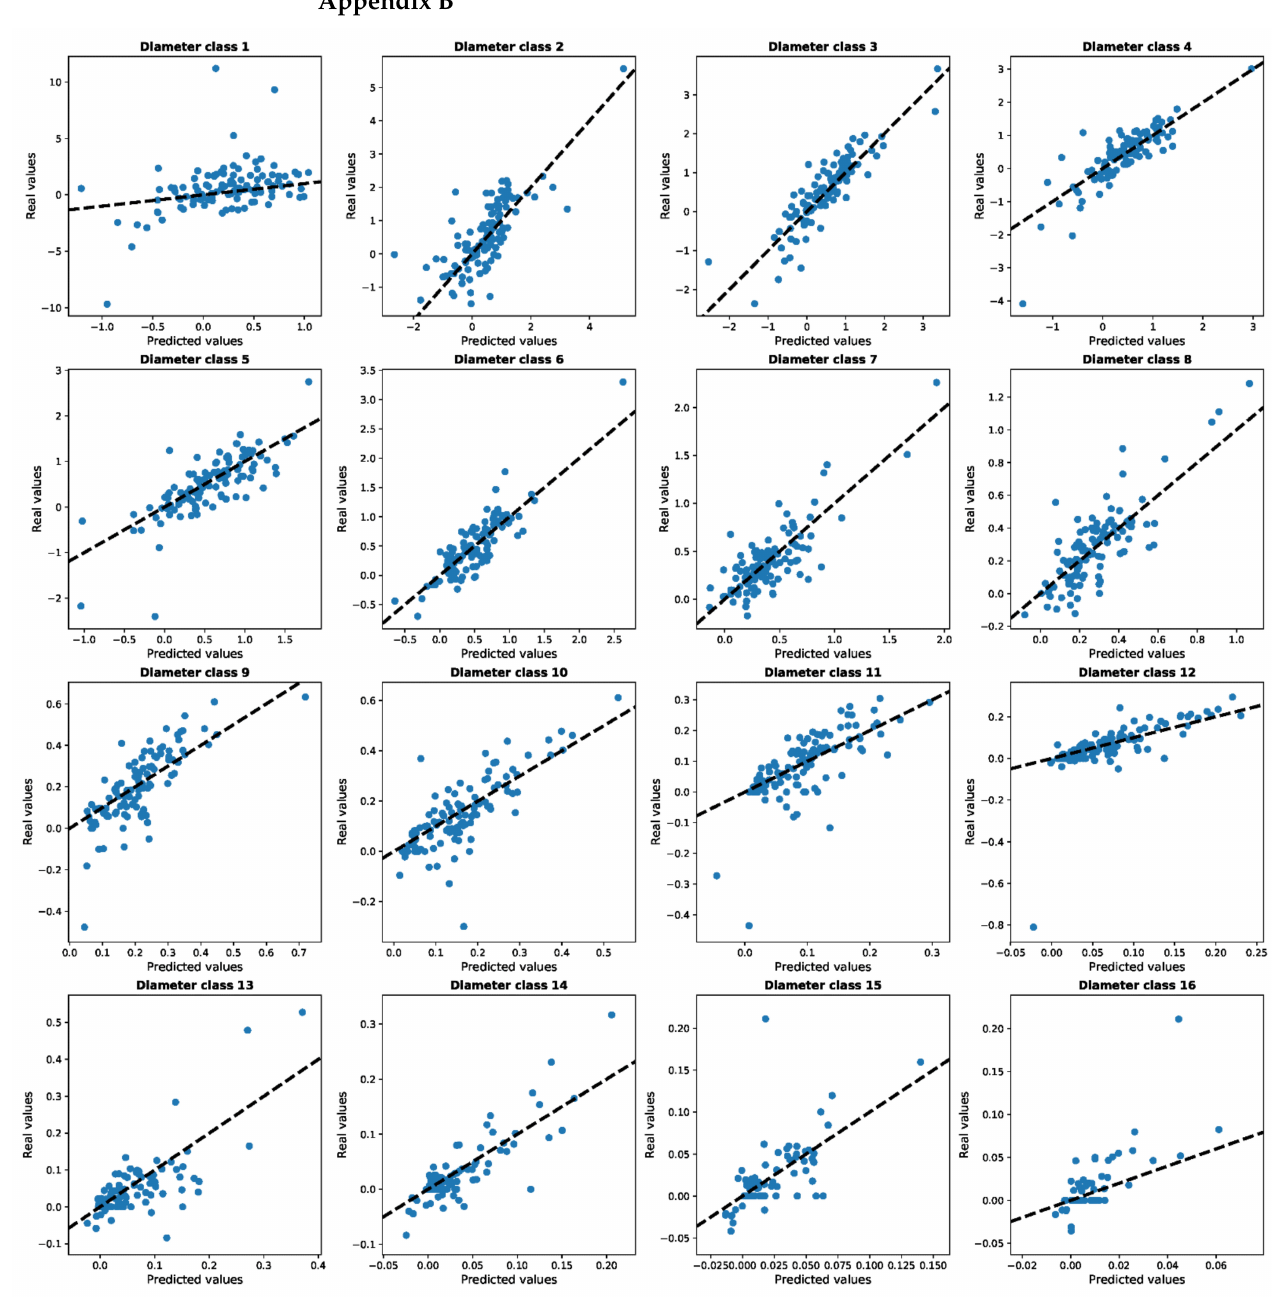
Figure A1. Residuals plots for linear models differentiated by diameter class presented in Equation (7) (classes from 1 to 16 where class center in cm = (#class − 1) × 5 +